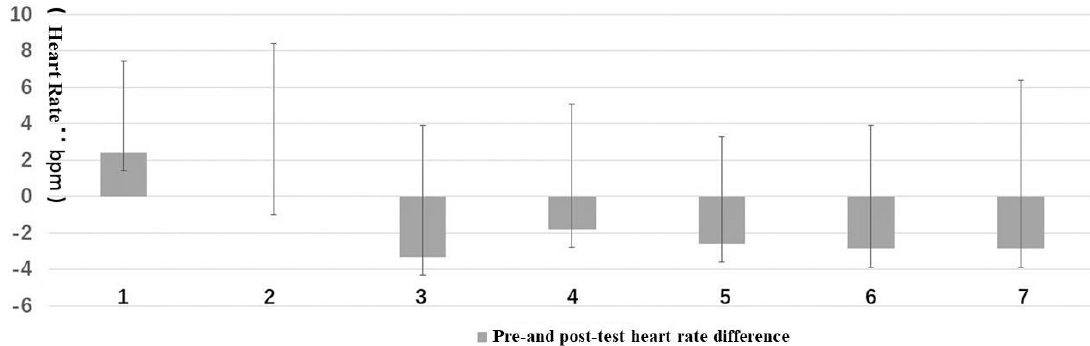
Figure 6. The mean of the ∆ D of heart rate: ( 1 ) structure, ( 2 ) wood, ( 3 ) wood with bench, ( 4 ) wood with platform and bench, ( 5 ) platform with trees, ( 6 ) waterfall with trees, and ( 7 ) pool with plants.